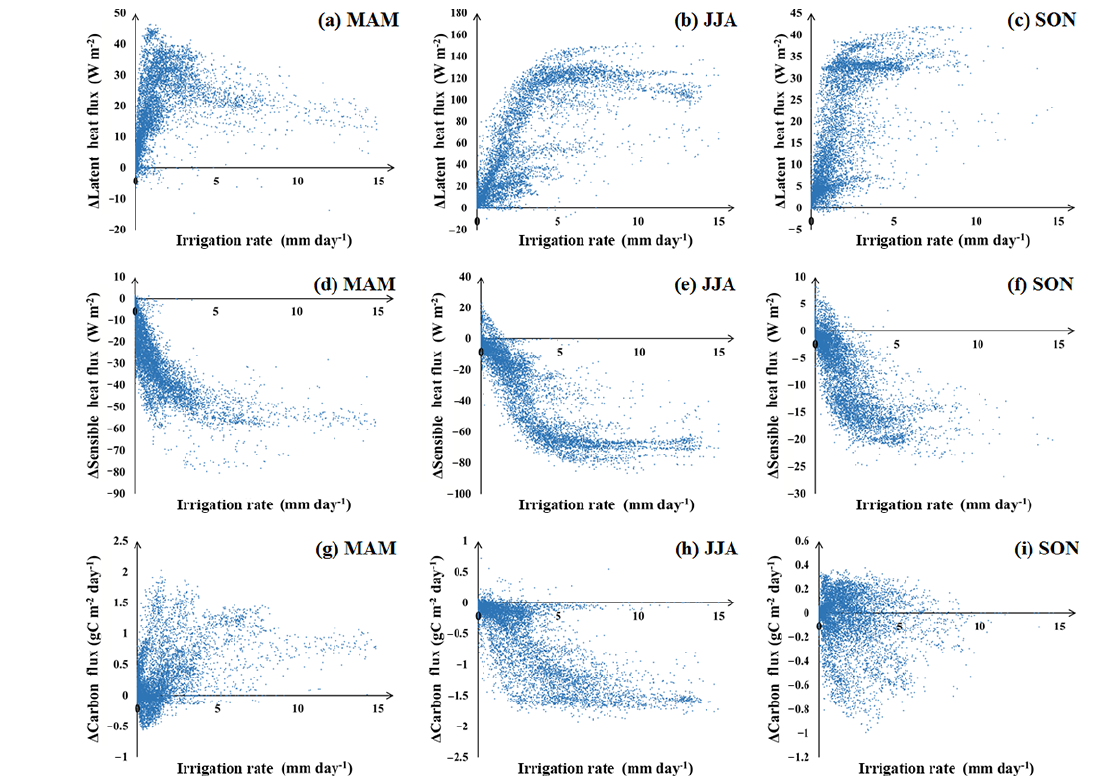
Figure 9. Differences in (a–c) latent heat flux, (d–f) sensible heat flux, and (g–i) carbon flux between IRR and CTL models versus the irrigation rate in (a, d, g) spring, (b, e, h) summer, and (c, f, i) autumn.